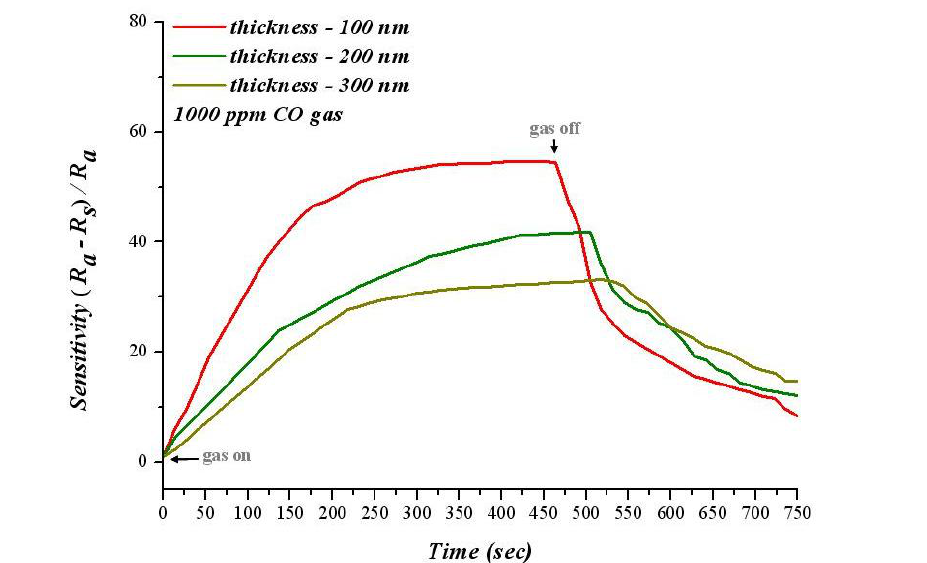
Figure 10. Relation between temperature and sensitivity for various SnO thicknesses (T = 280